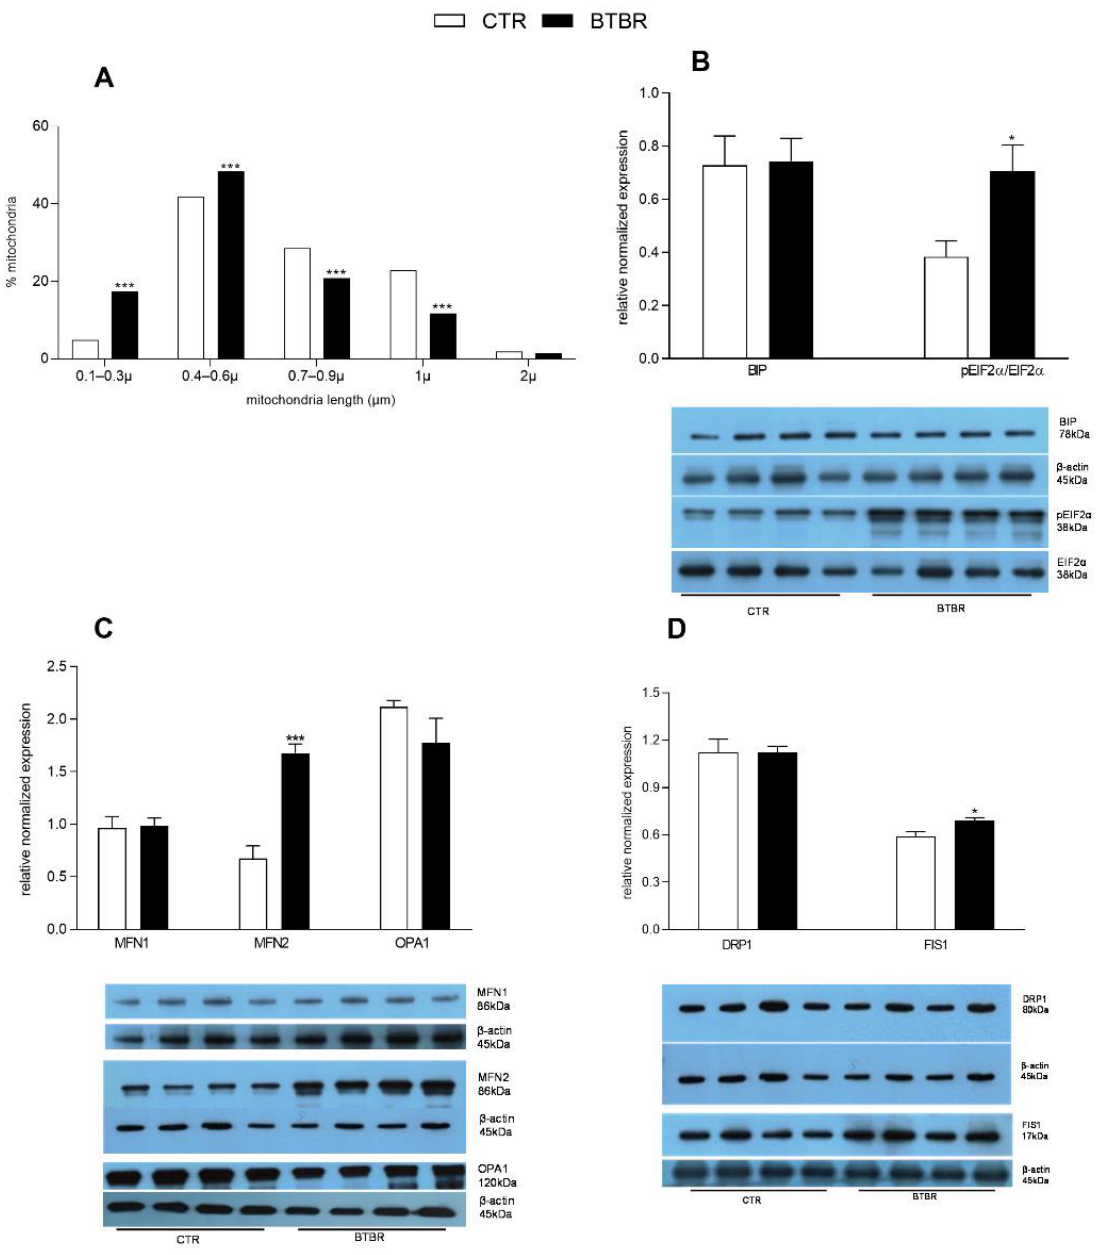
Figure 5. Hepatic markers of the endoplasmic reticulum stress and mitochondrial dynamics in control and BTBR mice. Percentage and length of mitochondria detected by histological analyses ( A ). Hepatic expression levels of endoplasmic reticulum stress markers: Binding Immunoglobulin Protein (BIP) and phosphorylated eukaryotic translation initiation factor 2A (pEIF2 α ), as ratio pEIF2 α /EIF2 α ( B ). Expression levels of markers of mitochondrial dynamics: fusion-related proteins mitofusin 1 (MFN1), mitofusin 2 (MFN2) and optic atrophy protein (OPA1) ( C ), and fission-related dynamin-related protein (DRP1) and fission 1 protein (FIS1) ( D ). (n = 4 animal/group). * p < 0.05, ** p < 0.01, *** p < 0.001, BTBR vs. Control (CTR).